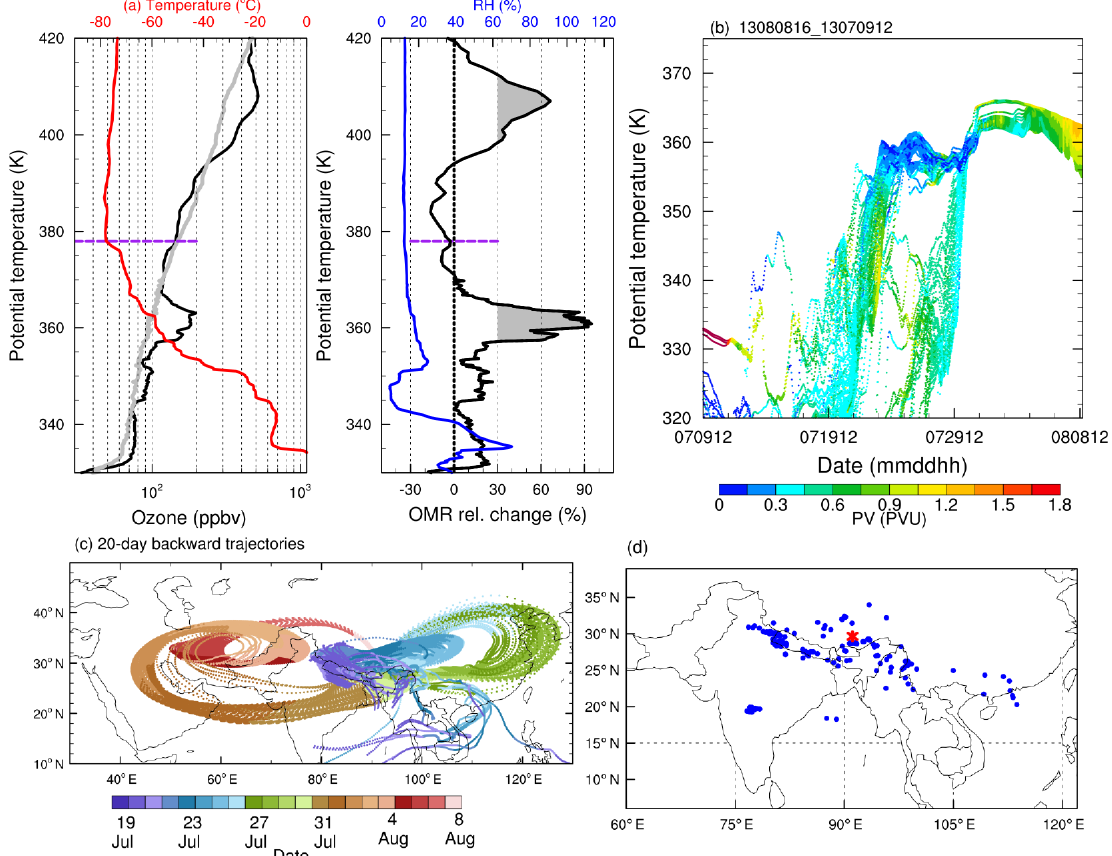
Figure 2. (a) Vertical profiles of ozone (black), monthly mean ozone (grey), and temperature (degree in red), OMR relative change (black), and relative humidity (blue) in Lhasa on 8 August 2013, 14:00UTC. The horizontal line marks the lapse-rate tropopause. (b) Potential vorticity (1PVU = 10 6 Km 2 kg − 1 s − 1 ; PVU stands for the unit of potential vorticity) along the 30-day backward trajectories of air parcels within the high ozone layer (355–362.3K) as a function of time and potential temperature. (c) The 20-day backward trajectories of air parcels between 355 and 362.3K at the Lhasa site on 8 August 2013 are shown colour-coded by date. (d) Geolocation of air parcels experienced strong uplift in the positive ozone mixing ratio anomalies. The red asterisk marks the location of